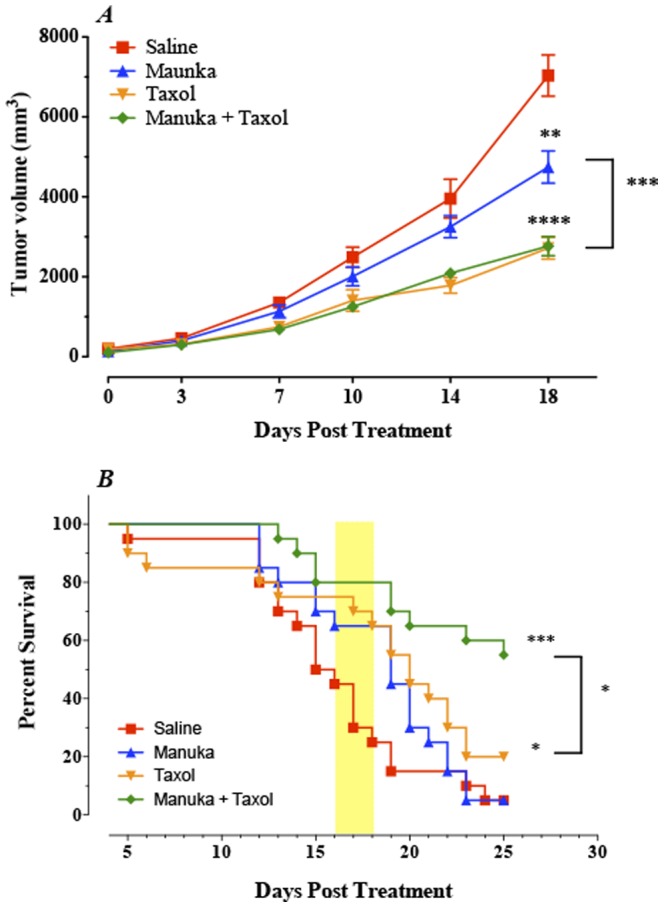
Effect of systemic administration of manuka on tumor growth and host survival.(A) Animals with established tumors were treated i.v. with either manuka honey (50% w/v), taxol (10 mg/Kg), manuka+taxol, or saline as control. All treatments were given twice per week until the end of observation period. Each data point represents the mean ± SEM of 19–20 mice per group, pooled from 2 individual experiments. Asterisks denote statistically significant differences between each experimental group and the saline control group; also shown is a comparison between manuka alone and manuka+taxol groups (**, p<0.01; ***, p<0.001). (B) Co-treatment with taxol and manuka leads to a significant enhancement in host survival. Experimental animals were followed for survival for up to day 25 post treatment. Each data point represents the mean ± SEM of 19–20 mice per group, pooled from 2 individual experiments. Asterisks denote statistically significant differences between experimental and saline control groups; also shown is a comparison between taxol alone and manuka+taxol groups (**, p<0.01; *, p<0.05).